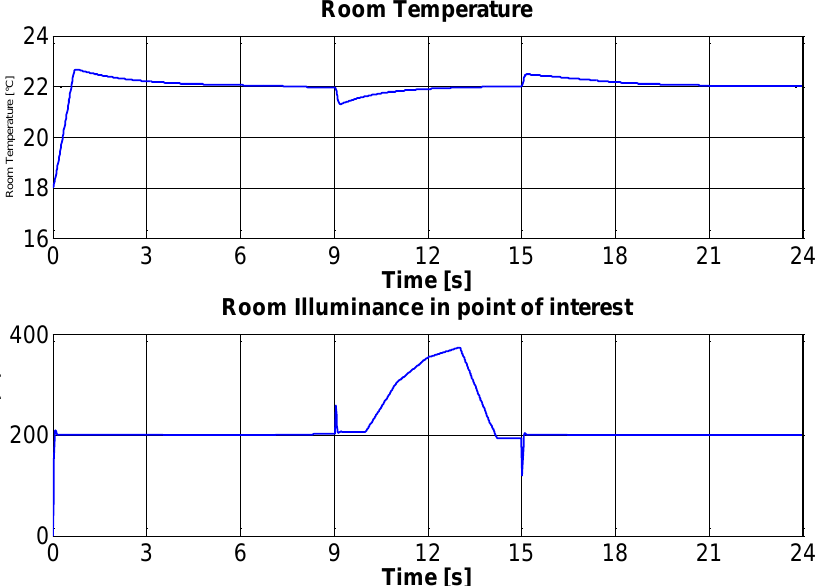
Figure 26. Control results (first scenario, initial control system, Energy Saving policy): room temper- ature and room illuminance (CVs).